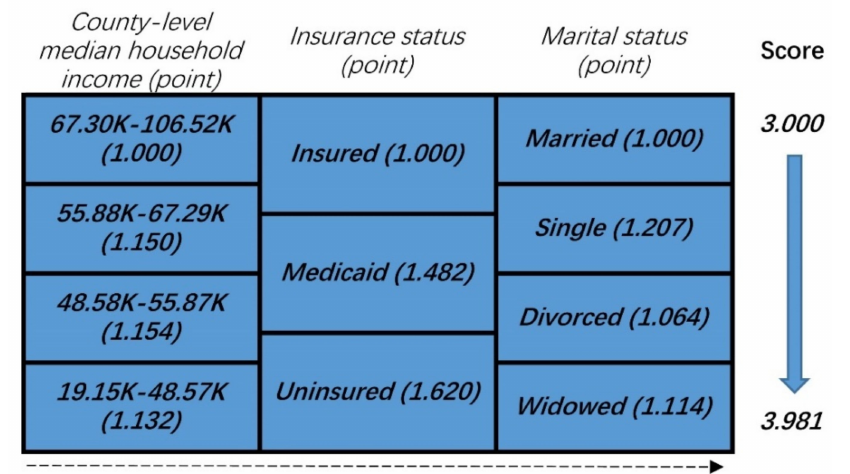
Figure 2. Patient prognostic score in colon cancer: